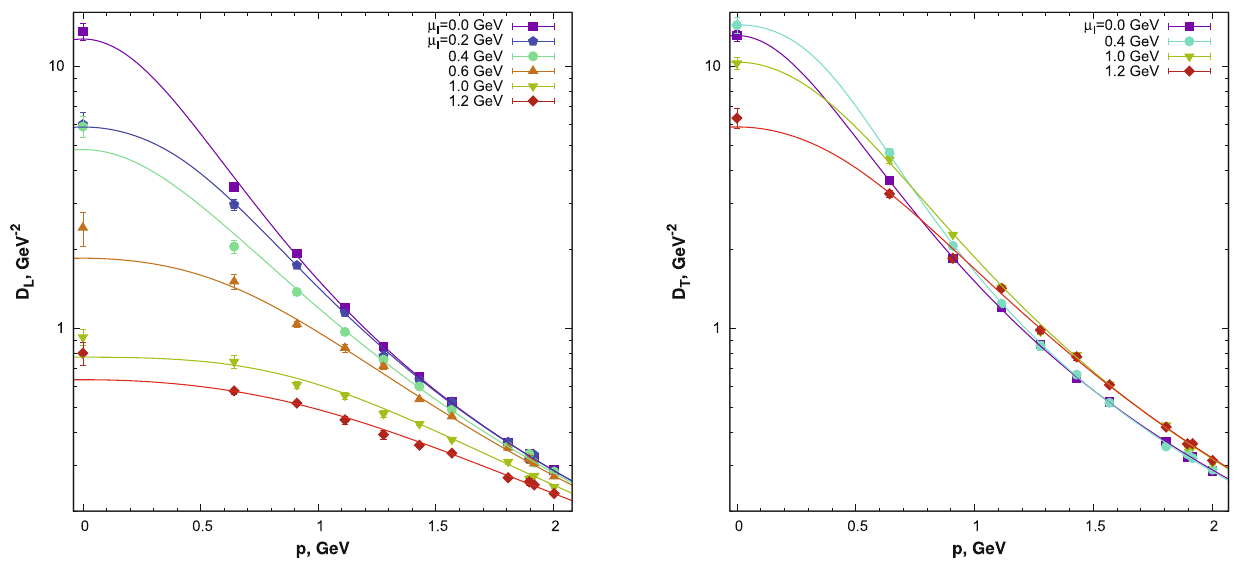
Fig. 3 The propagators D L (left) and D T (right) as functions of p at different values of μ I . The curves correspond to the formula (23)